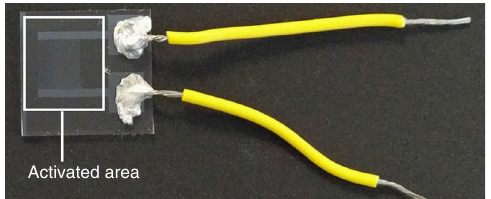
Fig. 5 The photo of a sample. Glass substrate is patterned with IDE. LCN is coated on top of the electrodes (highlighted by the white square). Two wires are attached to the contact pad of the IDE to connect to the power